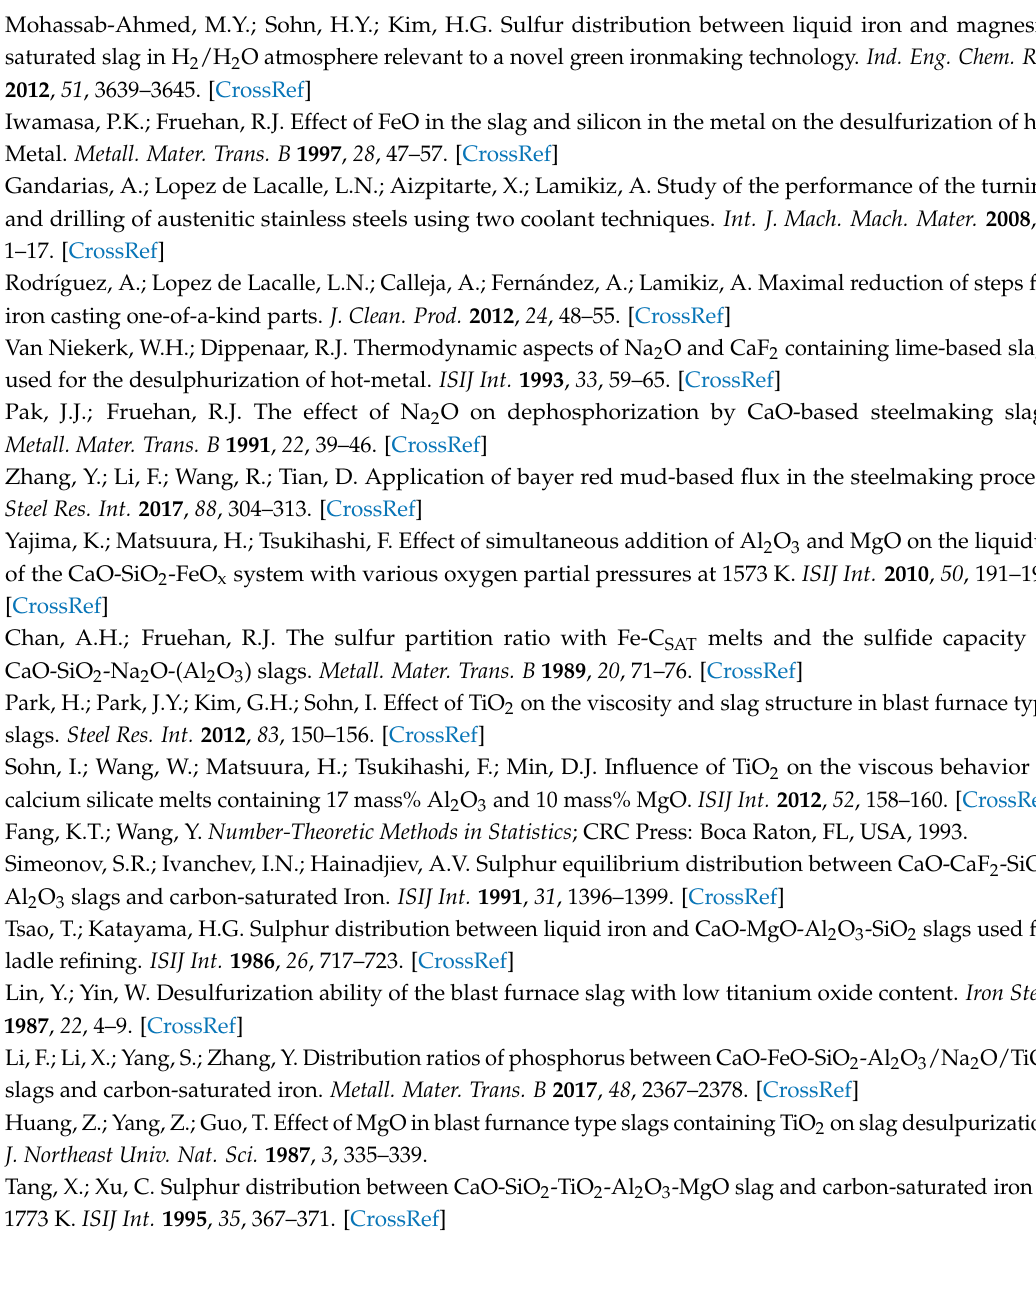
Based on the experimental data, for the distribution ratio of sulfur between CaO-SiO 2 -Al 2 O 3 - Na 2 O-TiO 2 slag and carbon-saturated iron, the following fitting formula is